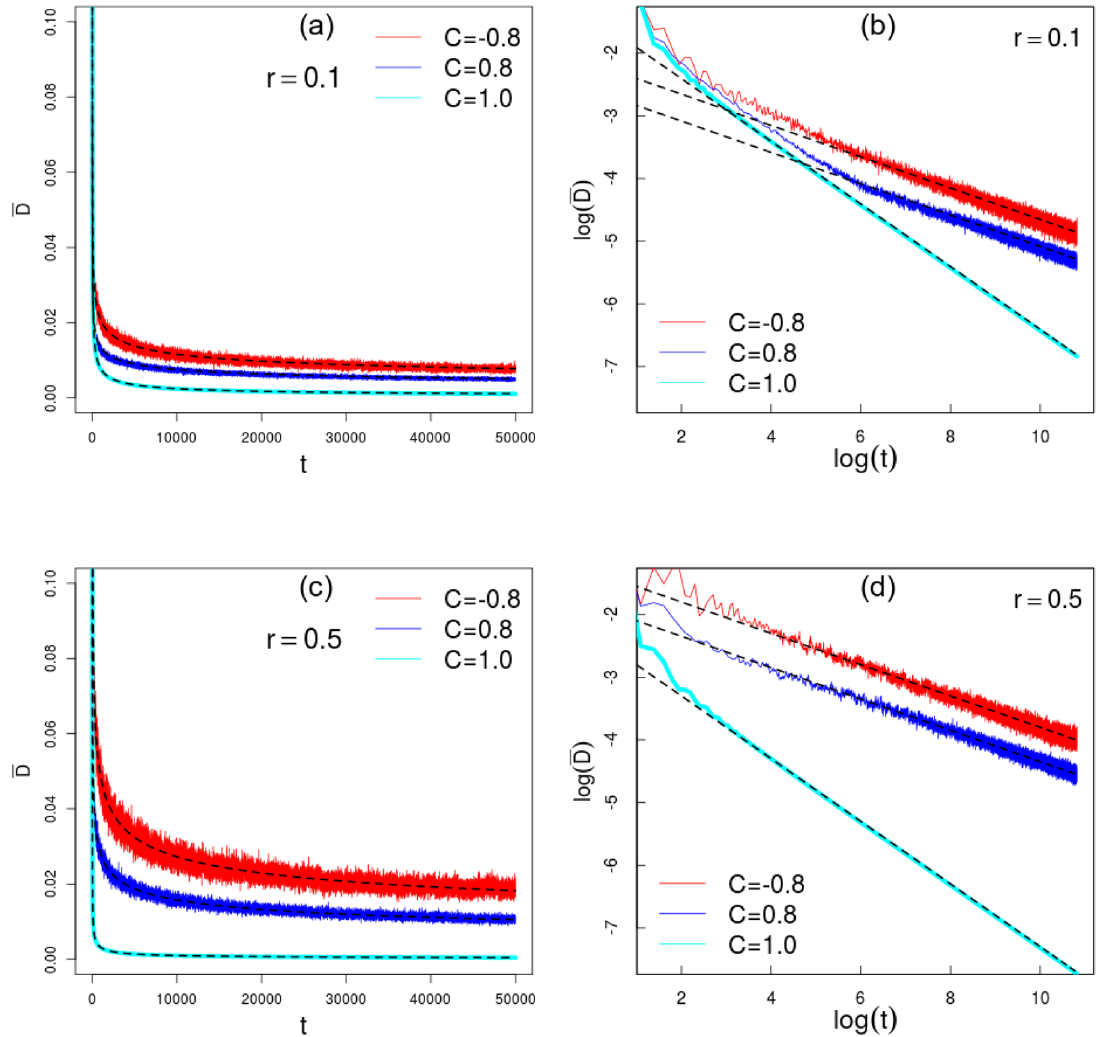
Figure 6. Time series for the average trace distance between states at adjacent instants. Outcomes for disorder 0.1, 0.5 0.8, 0.8, 1 strength r as well as C . Full lines are obtained with 100 samples, except for the = { } = {− } 1 . The superimposed dashed lines are the fits (values in Table 1) that are obtained nonrandom QW with C = after discarding 5 initials steps in order better describe the long-run tendency.